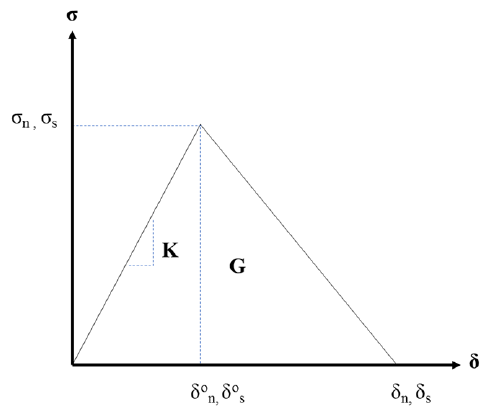
Figure 3. Bilinear traction–separation law [94].